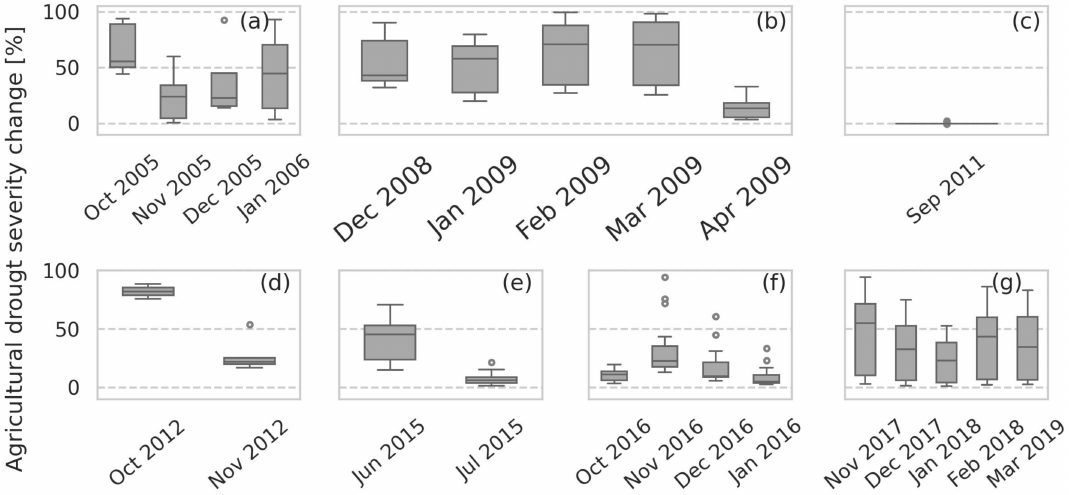
Figure 12. Agricultural drought severity changes in subbasins where check dams and ponds are applied: event I ( a ), event II ( b ), event III ( c ), event IV ( d ), event V ( e ), event VI ( f ), and event VII ( g ).